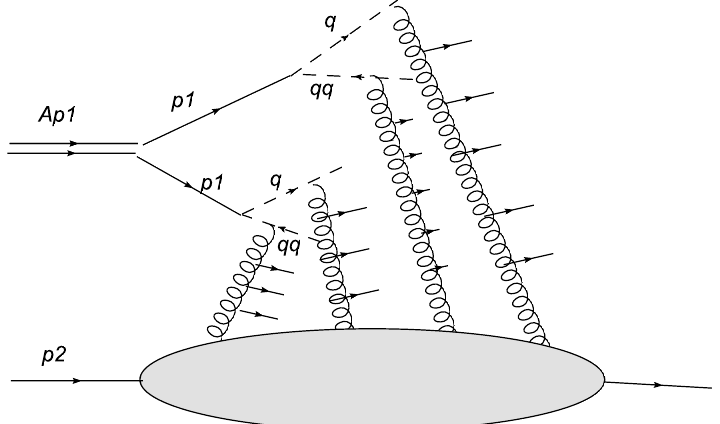
Figure 1. pA collision for A = 2, with creation of four color strings; nucleons of the projectile are shown by solid lines, and the partons into which they split (quarks and diquarks) by dashed lines.